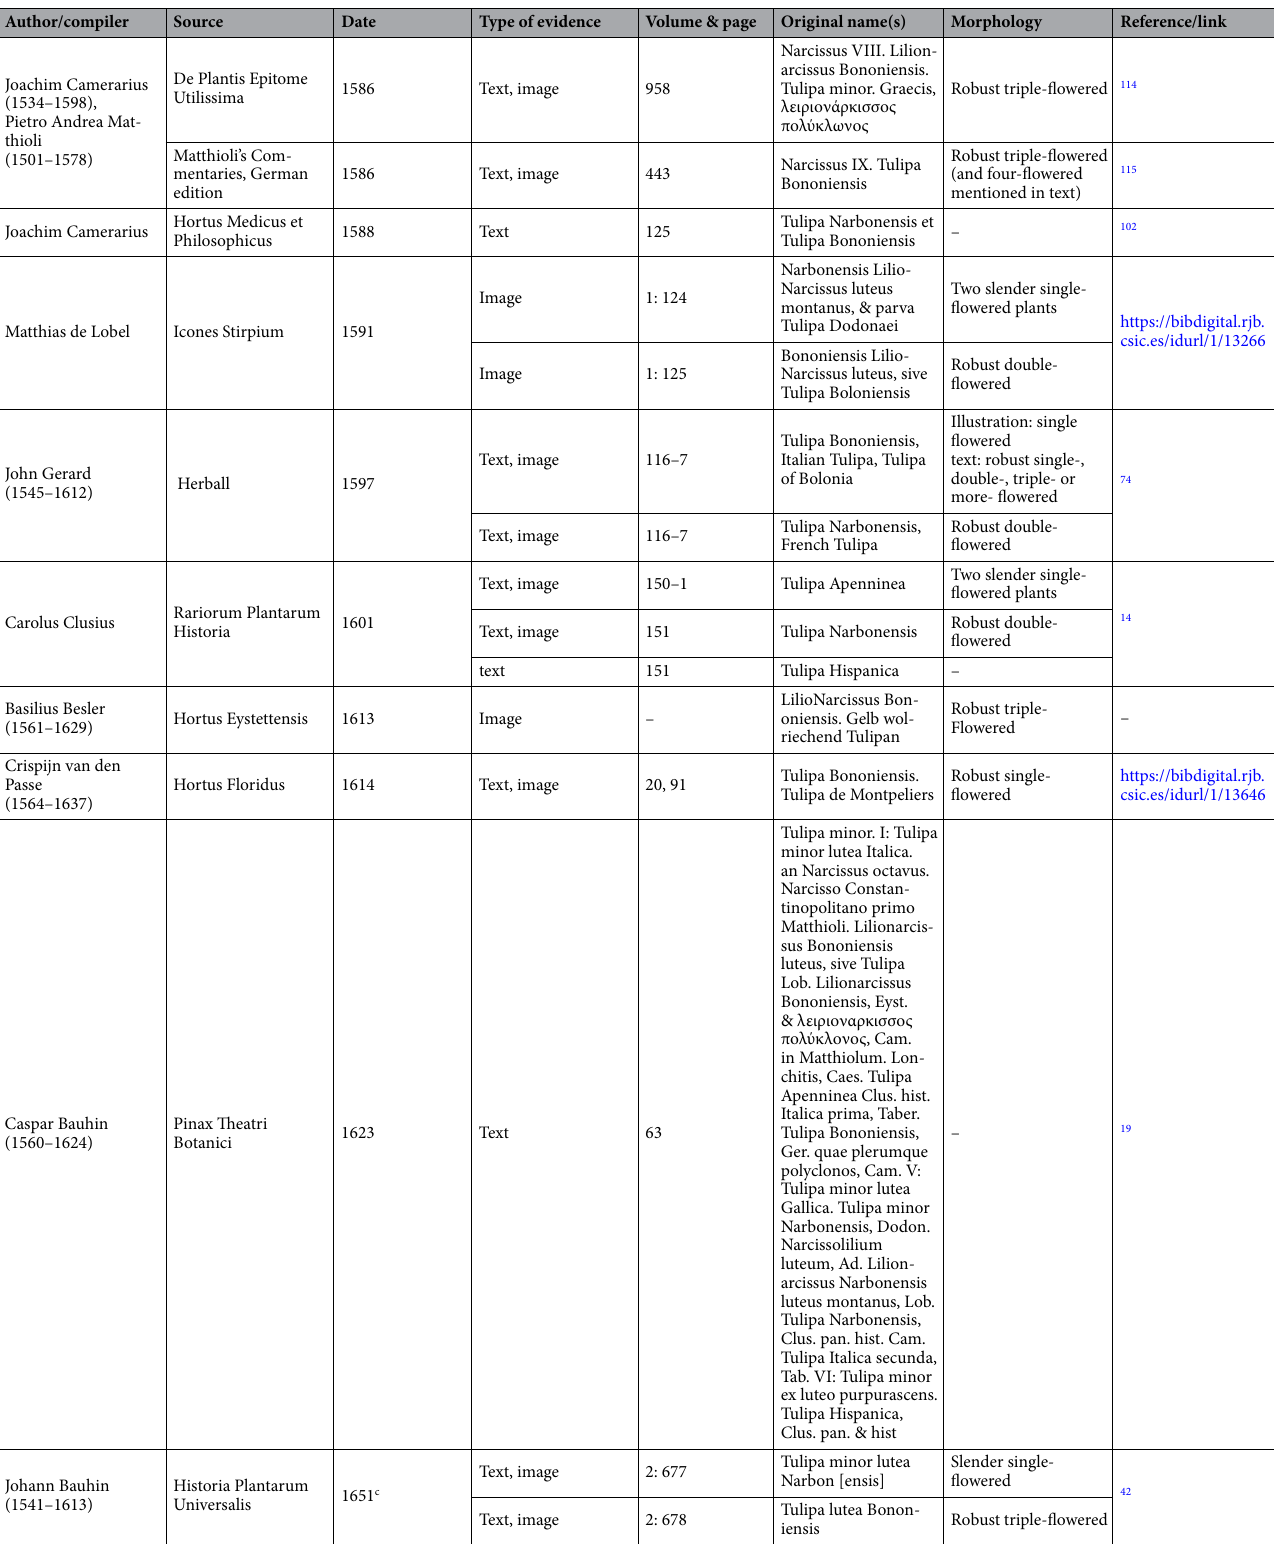
Table 1. Tulipa sylvestris in sixteenth-century botanical books and drawing collections. Morphology is given when an image (illustration) is available. The indication “robust” or “slender” is an approximate estimation of flower size and leaf width. Links to the original sources are provided where available online in the last column or the list of references. a Refers to Kentmann’s illustration of 1549. b Dating estimated herein based on the fact that de Lobel and the epithet “ Bononiensis ” are not mentioned in the plant names. c Published